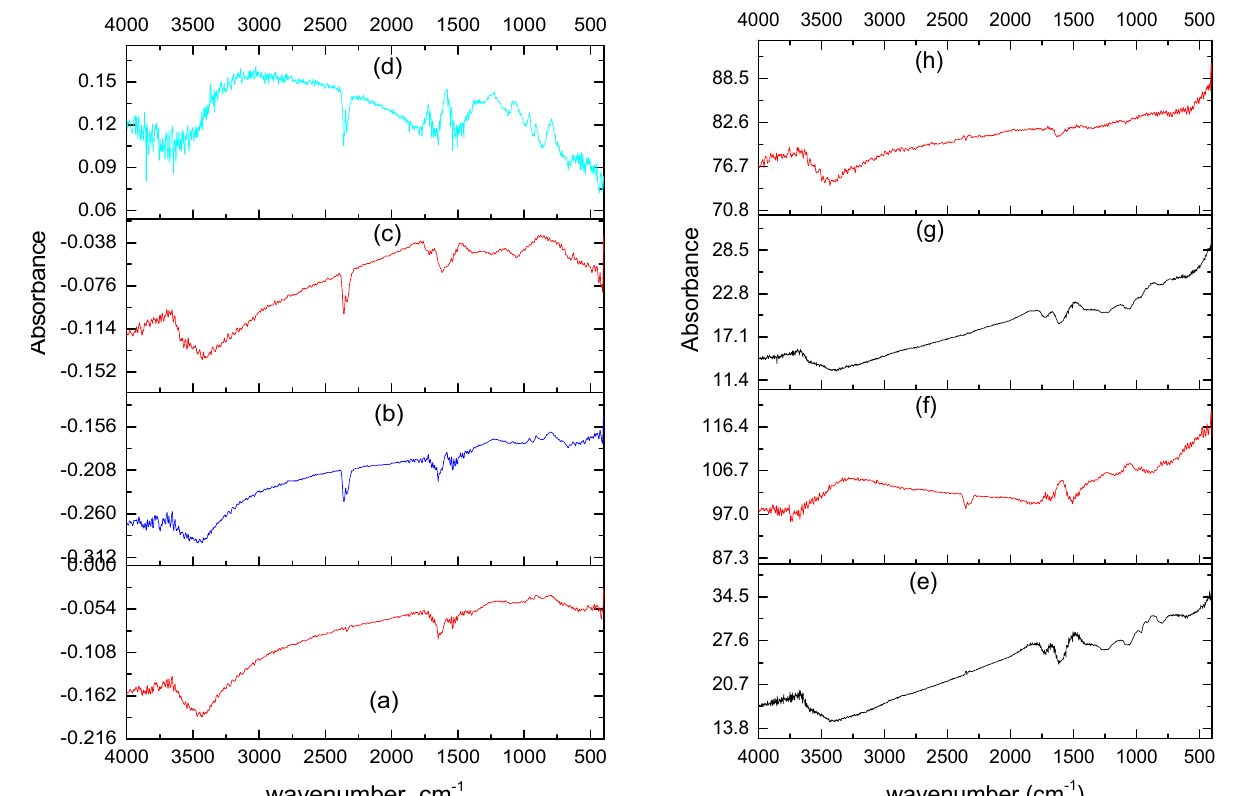
Figure 8. IR spectra for ( a ) [GO 70 POM] 18 , ( b ) [GO 70 POM] 18 after Cs adsorption, ( c ) [GO 70 POM] 41 , ( d ) [GO 70 POM] 41 after Cs adsorption, ( e ) [GO 40 POM] 18 , ( f ) [GO 40 POM] 18 after Cs adsorption, ( g ) [GO 40 POM] 41 , and ( h ) [GO 40 POM] 18 after Cs adsorp- tion.